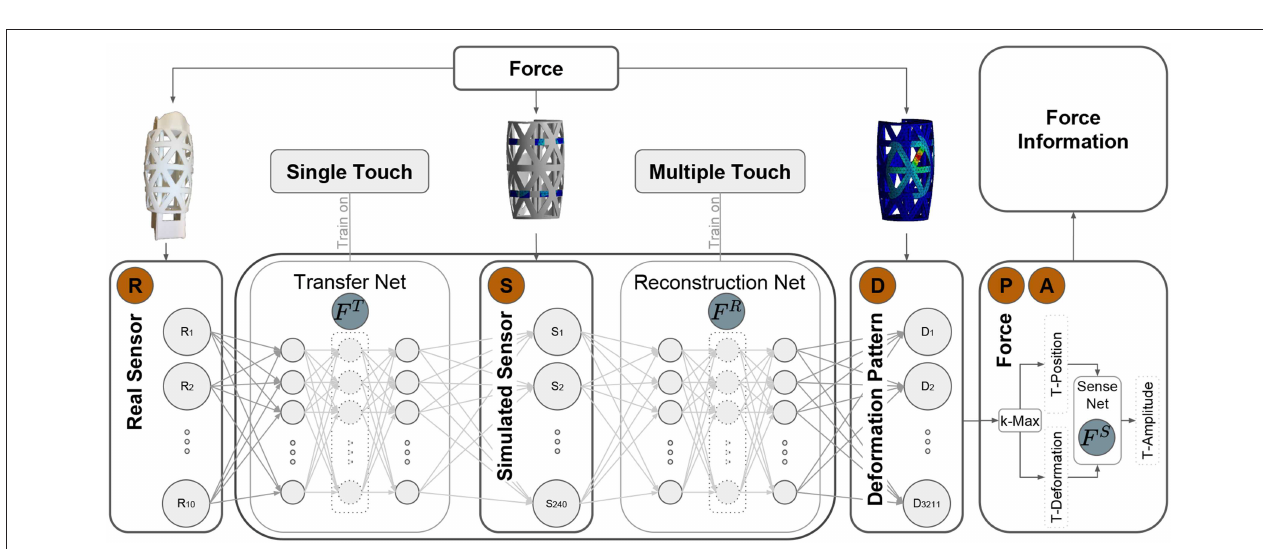
FIGURE 1 | Overall goal of the method: inferring multi-contact haptic stimulation from a few sensors measuring internal deformation.